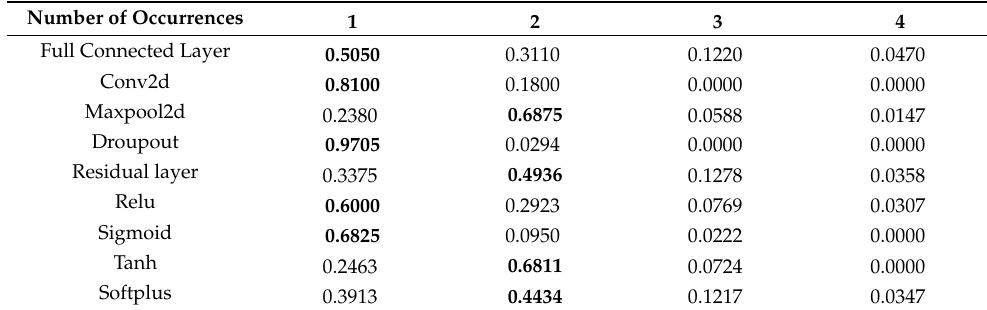
Table 16. Layer occurrence